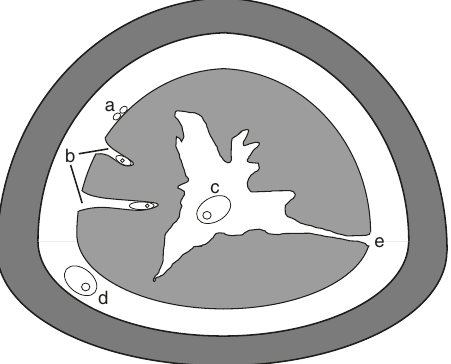
Supplementary Table 1. The stained samples were scanned using an X-ray microCT system (ScanXmate-E090S105; Comscan Techno) at a tube voltage peak of 60 kV and a tube current of 110 μ A. During scanning, samples were rotated 360 degrees in steps of 0.14 to 0.18 degrees, generating 2000 – 2500 projection images. Images were reconstructed using the software provided with the X-ray microCT system (coneCTexpress; Comscan Techno). 2D and 3D tomographic images were obtained using the OsiriX (www.osirix-viewer.com) software program.